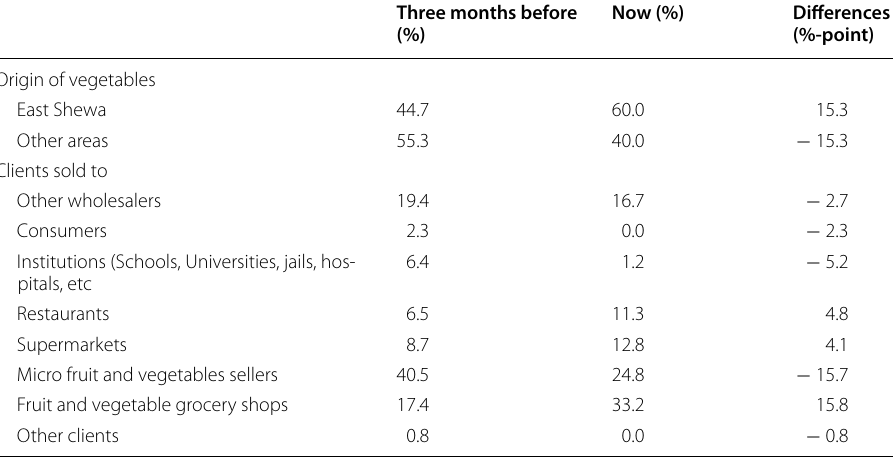
Table 1 Procurement locations and sales patterns of urban wholesalers before and after the onset of COVID-19